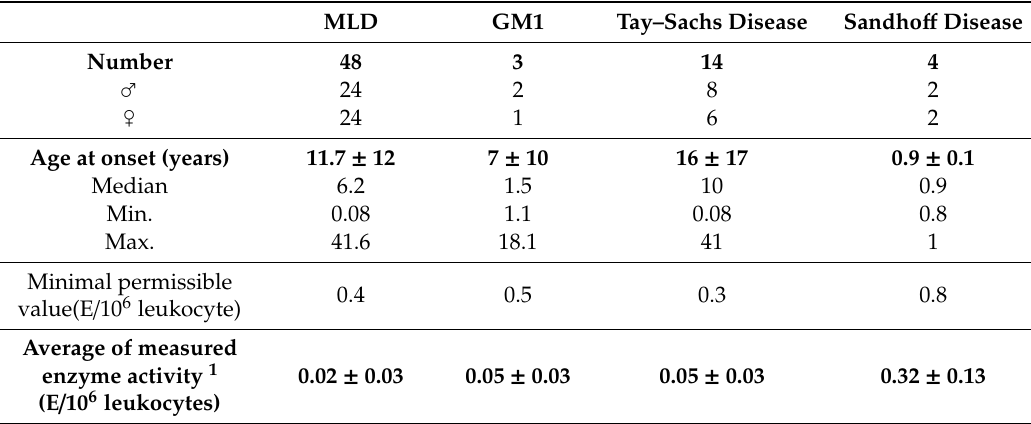
Table 2. Detailed characterization of the pathological cohort.